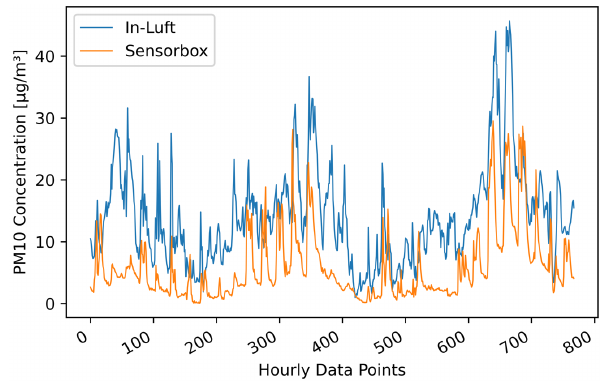
Figure 15. PM 10 hourly mean data recorded with mobile pilot sensor-box 6 located in Ebikon in the period from 15 October 2021 to 15 November 2021, compared to hourly mean data recorded at the in-luft station located in Ebikon, Sedel. Data gaps are removed from graph. Number of mean hourly values: 768; Resulting correlations: R P = 0.67, R S =